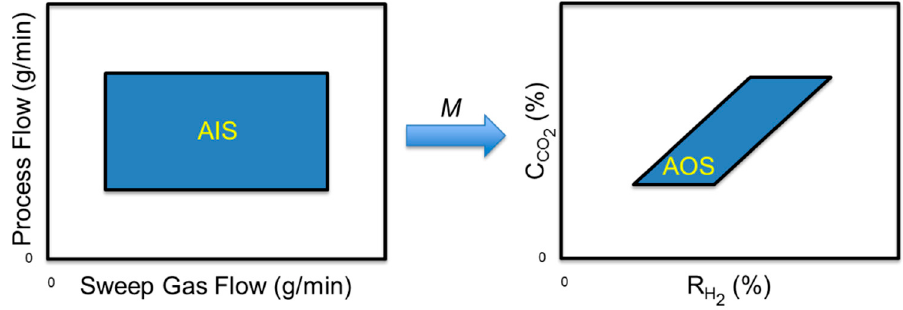
Figure 5. Example of an available input set (AIS) being mapped to an achievable output set (AOS) with the use of a process model ( M ).